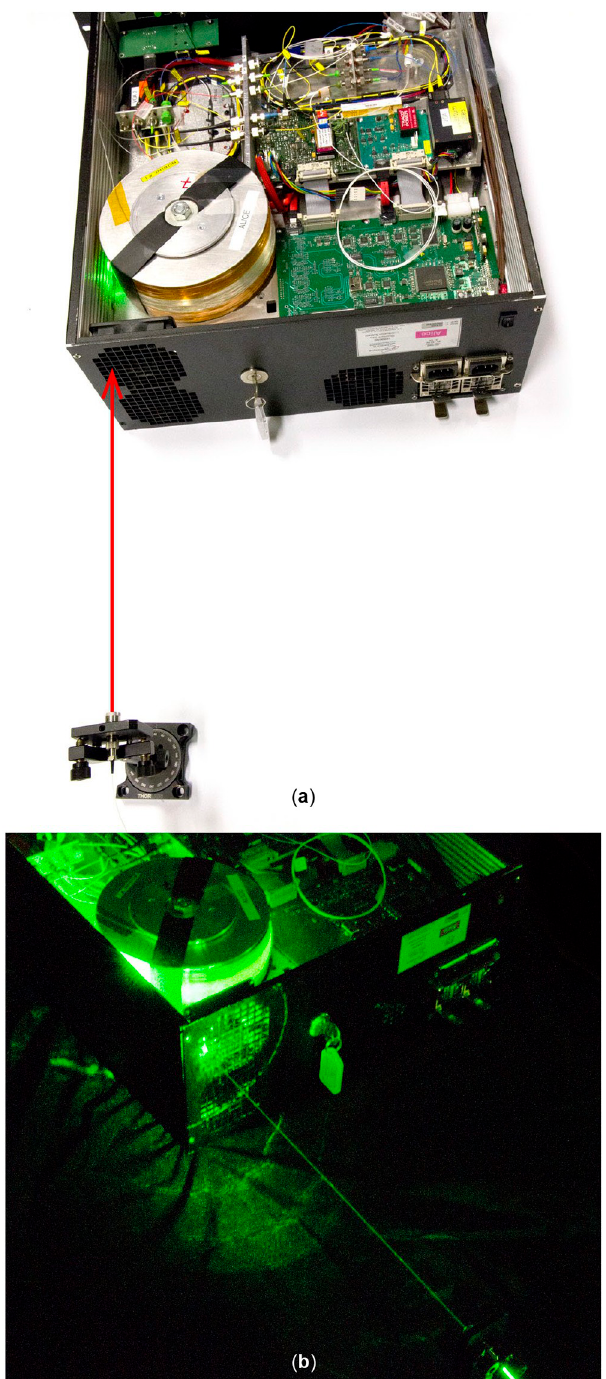
Fig 3. Experimental setup for QKD system Clavis2. (a) A collimated laser light beam (denoted by an arrow) from a fiber collimator passes the ventilation hole and couples to the delay line. We have removed a solid metal cover from the system to show its internals. (b) A picture taken in the dark shows how the light from the beam couples to the fiber spool (for this picture we used a visible green laser instead of 1536 nm).